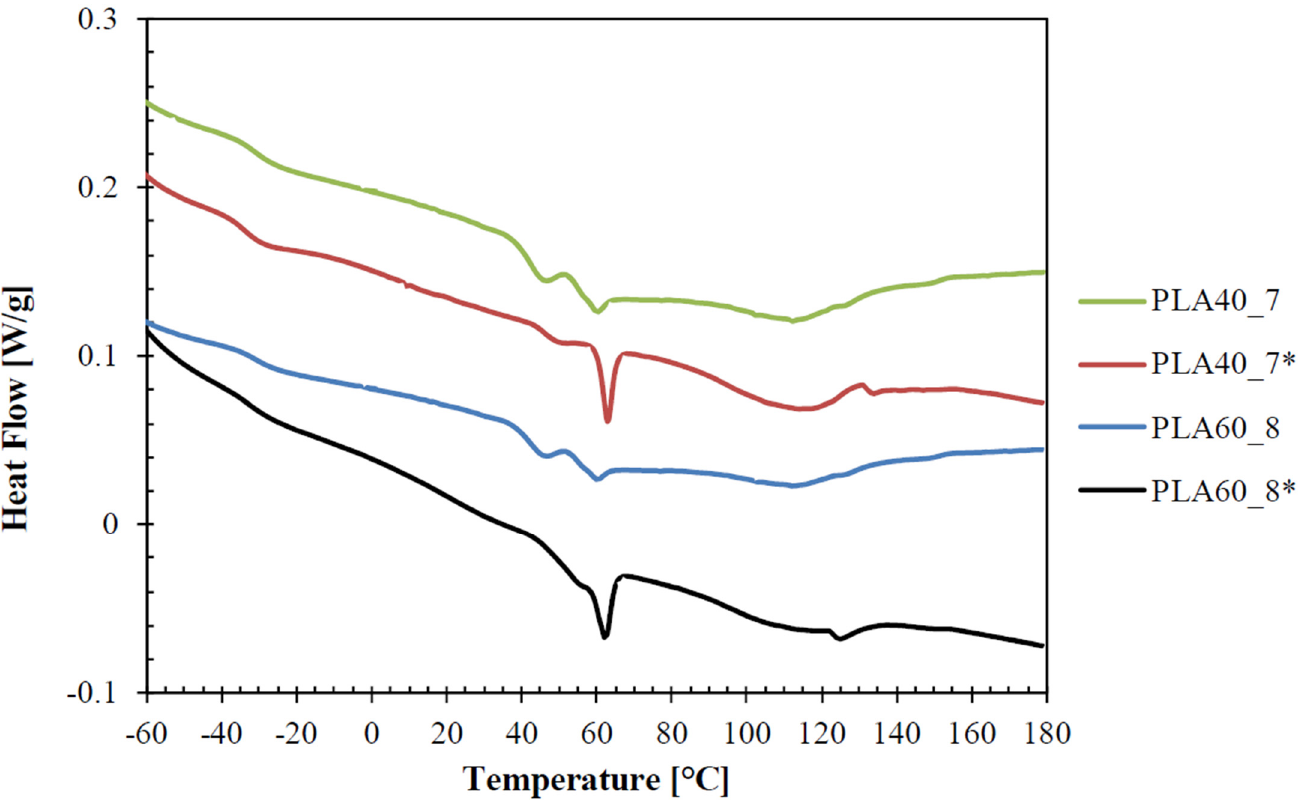
Figure 3. DSC thermograms of the films related to the first heating scan (samples named with the asterisk were produced without cooling air). Table 5. Thermal parameters of the films during the first heating scan (samples named with the asterisk were produced without cooling air).